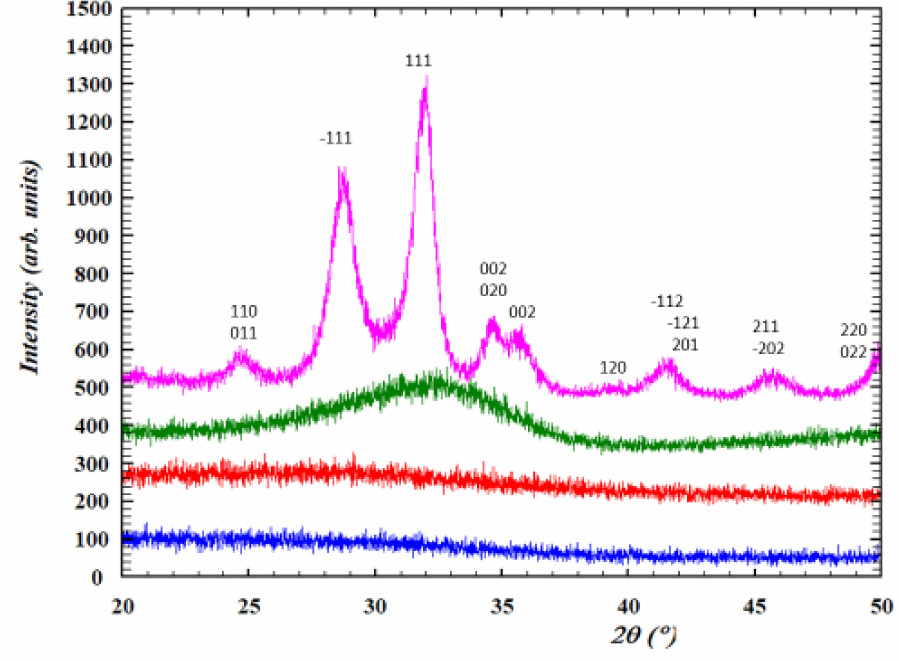
Figure 3. Grazing incidence X-ray diffraction patterns ( ω = 0.4 ◦ ) of HfO 2-DUV thin films as-deposited (blue), after DUV treatment at 200 mJ/cm 2 (red) and after DUV treatment and thermal annealing at 400 ◦ C for 1 h (green) or 600 ◦ C for 1 h